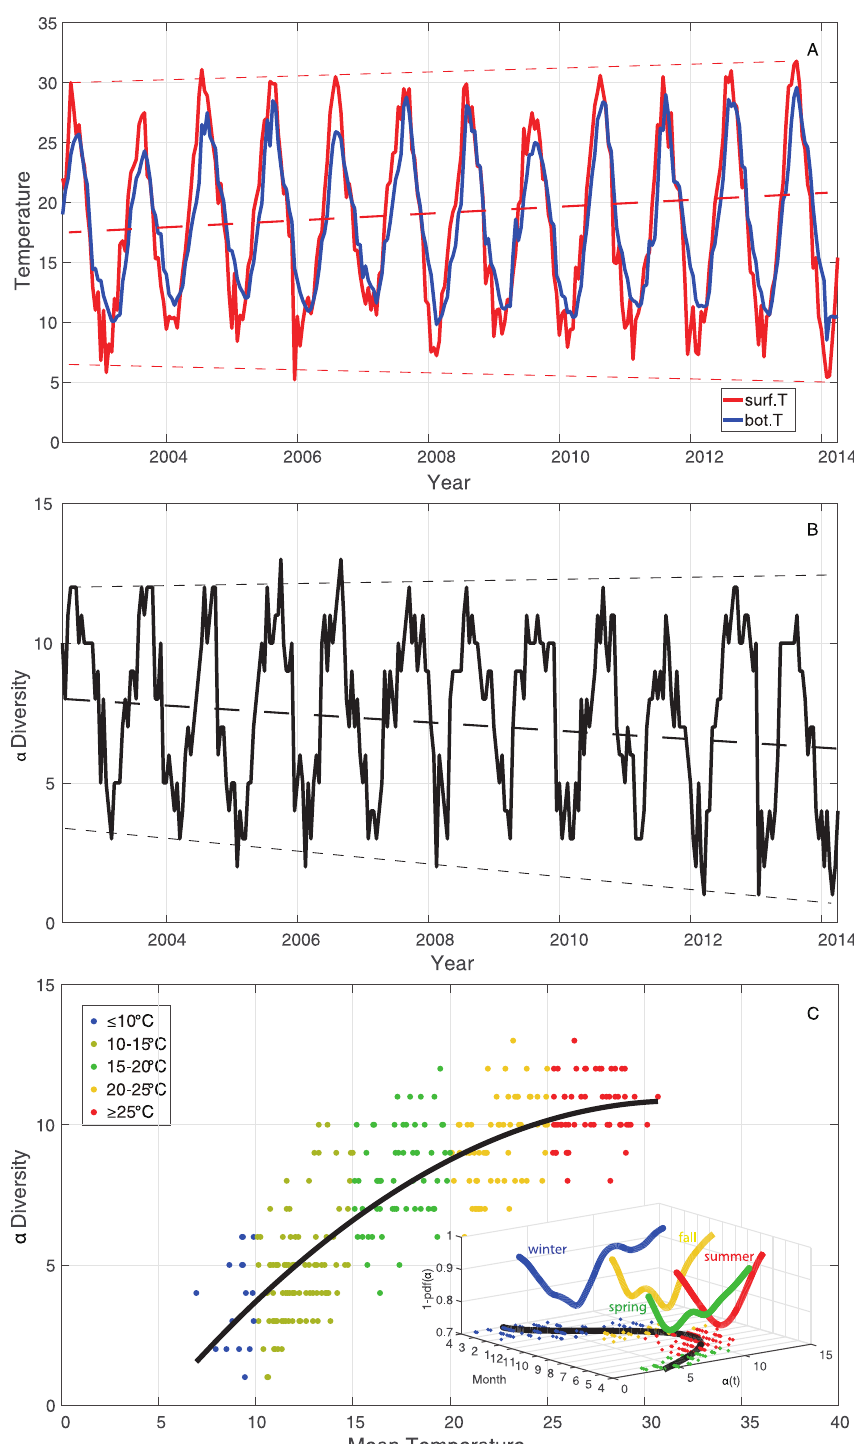
Fig 1. Seasonal fluctuations of ST and α -diversity and relationship with mean temperature. A : The sea surface temperature (red line) and bottom temperature (blue line) from June 2002 to April 2014. B : Taxonomic α -diversity over time. C : α -diversity over mean temperature (the average of sea surface and bottom temperature). Blue points, light green points, green points, yellow points and red points represent values of α -diversity corresponding to different TRs: � 10˚C, 10–15˚C, 15–20˚C, 20–25˚C, � 25˚C, respectively. The black curve in plot C is a second